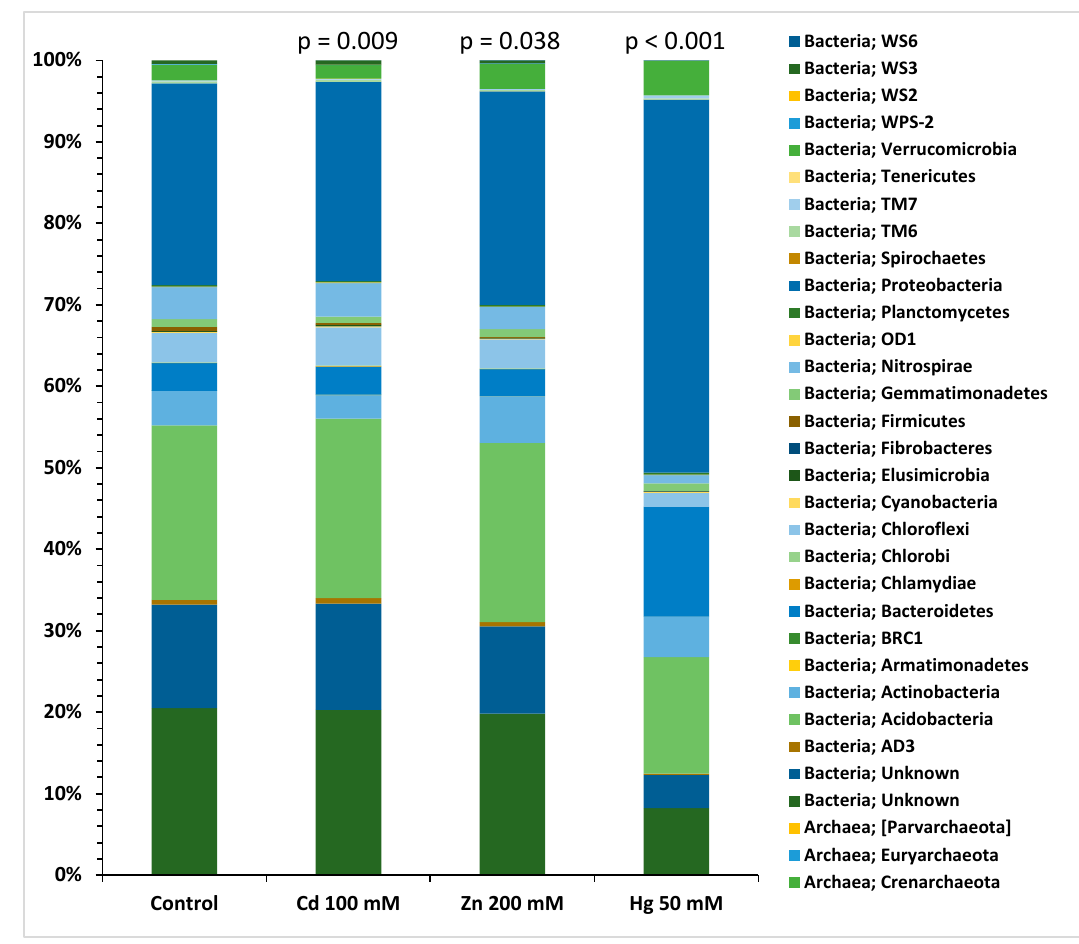
Figure 6. Assignment of 16S rRNA gene sequences to microbial phyla for selected HM-spiked microcosms (Cd 100 mM, Zn 200 mM and Hg 50 mM, control) soil samples after 6 weeks of incubation. p -values represent differences between data from HM and control samples. Table 2. Comparison of microbial 16S rRNA gene reads in various taxonomical levels of Cd-, Zn- and Hg-spiked microcosms compared to the control microcosm